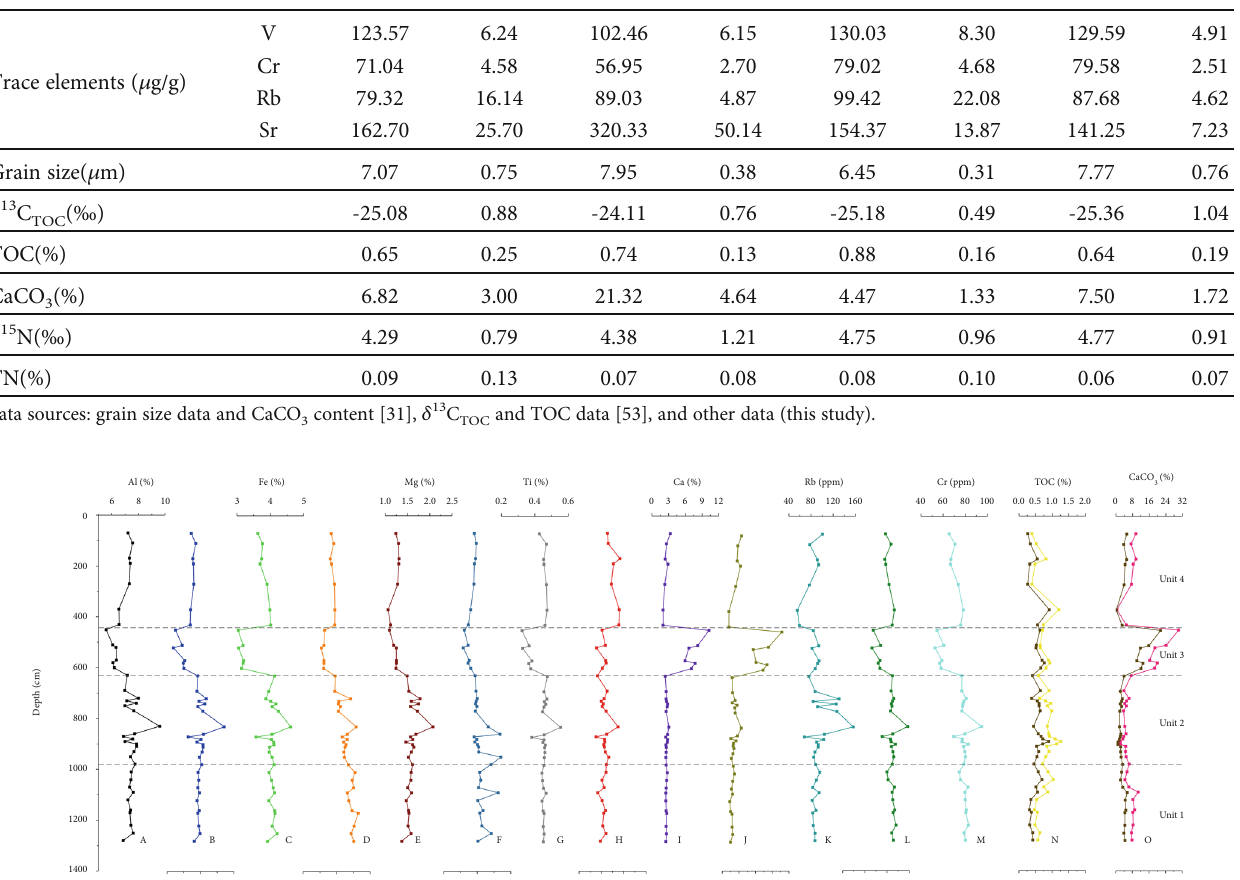
(red line) content, and their 3